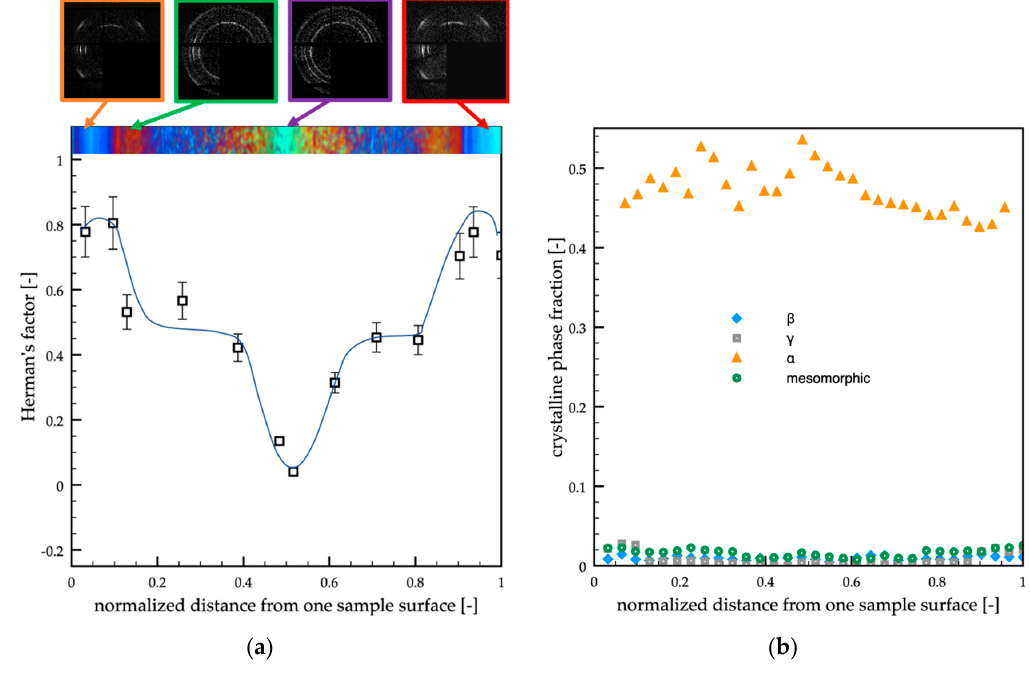
Figure 6. ( a ) WAXS analyses of the A molding in different positions along the sample thickness. Each analyzed position is indicated on the optical micrograph. The distribution of the orientation in terms of Herman’s factor was also reported. ( b ) Distributions of mesomorphic, α , β , and γ -phase